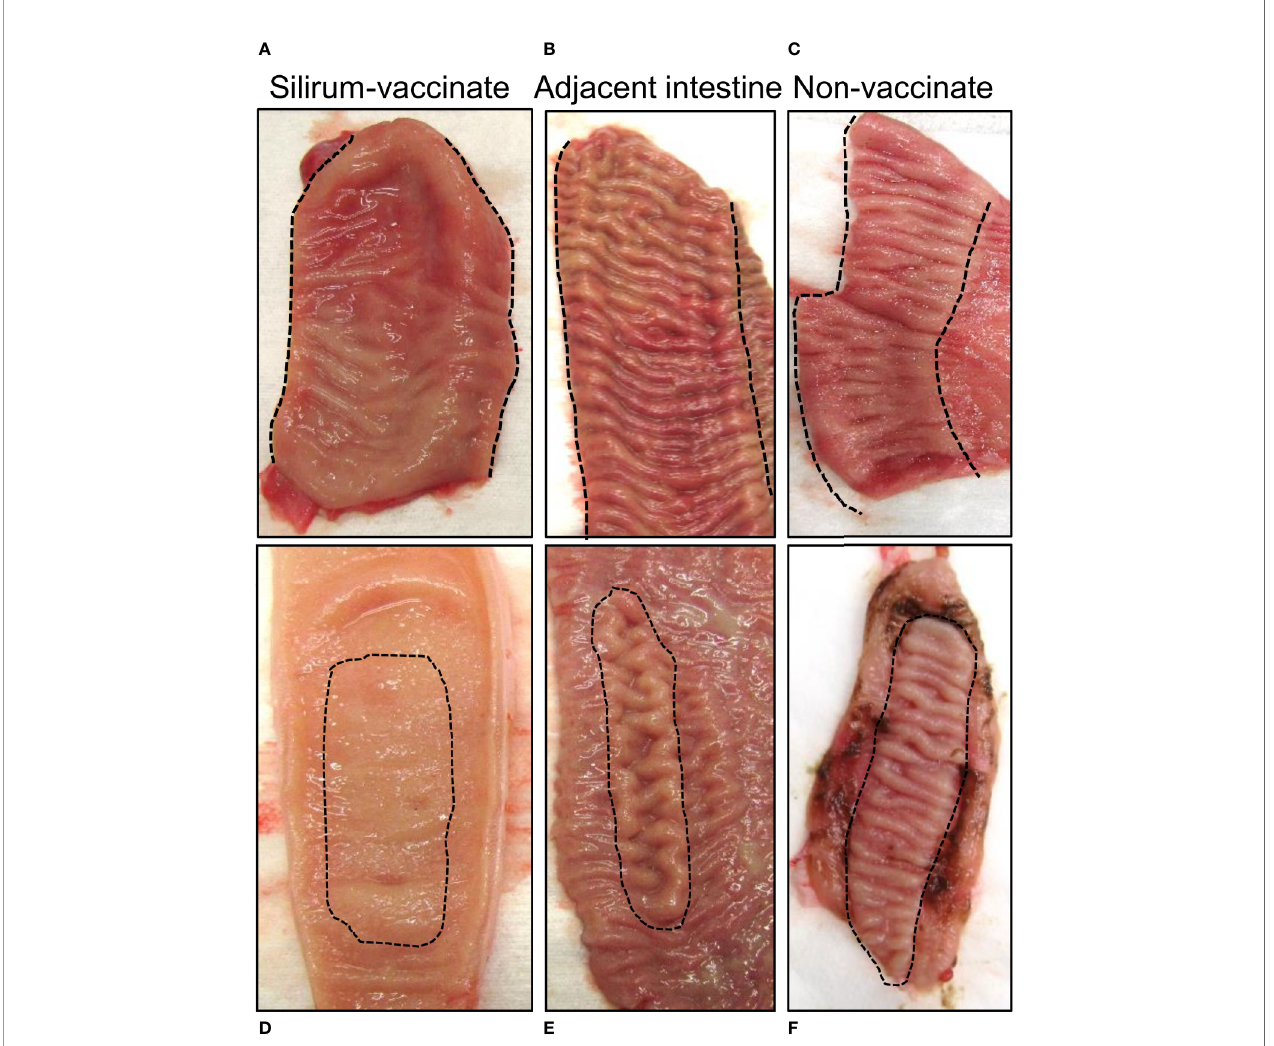
FIGURE 2 | Mucosal surface of the intestinal segments and adjacent intestine. Intestinal segments and adjacent intestine were collected at 28 days post-infection, and the mucosal surface exposed by dissecting along the mesenteric attachment. (A, B) Representative images of the mucosal surface of a terminal jejunal segment and adjacent intestine, respectively, from a Silirum vaccinated calf, and a (C) terminal jejunum segment collected from an unvaccinated calf. (D, E) Representative images of the mucosal surface a mid-jejunal segment and adjacent intestine, respectively, from a Silirum vaccinated calf, and a (F) mid-jejunum segment collected from an unvaccinated calf. Hash marks de fi ne the margins of the continuous band of PP (CPP) in the terminal jejunum, or the borders of the discrete PP (DPP) in